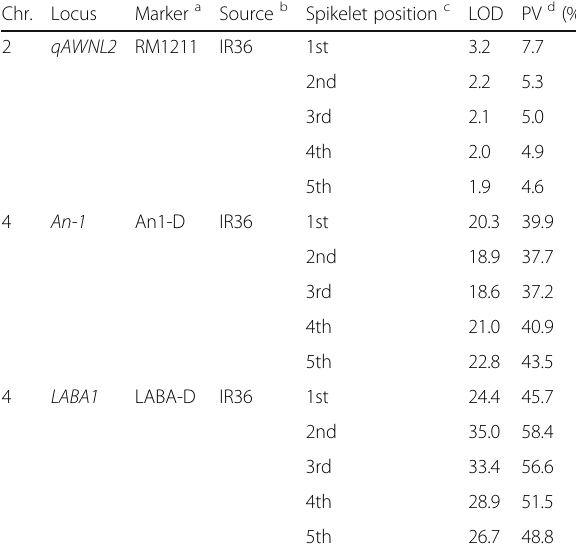
Table 2 Putative QTL locations for awnlessness detected in BC 3 F 2 population between O. rufipogon W630 and O. sativa IR36 Chr.